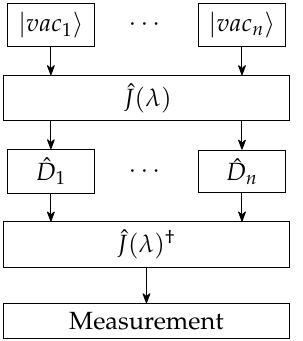
Figure 2. Quantum game